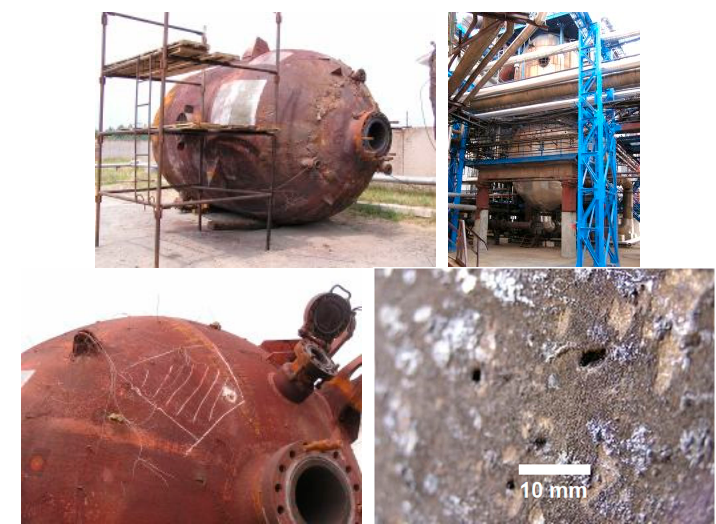
Figure 4. Breach of the cladding layer.